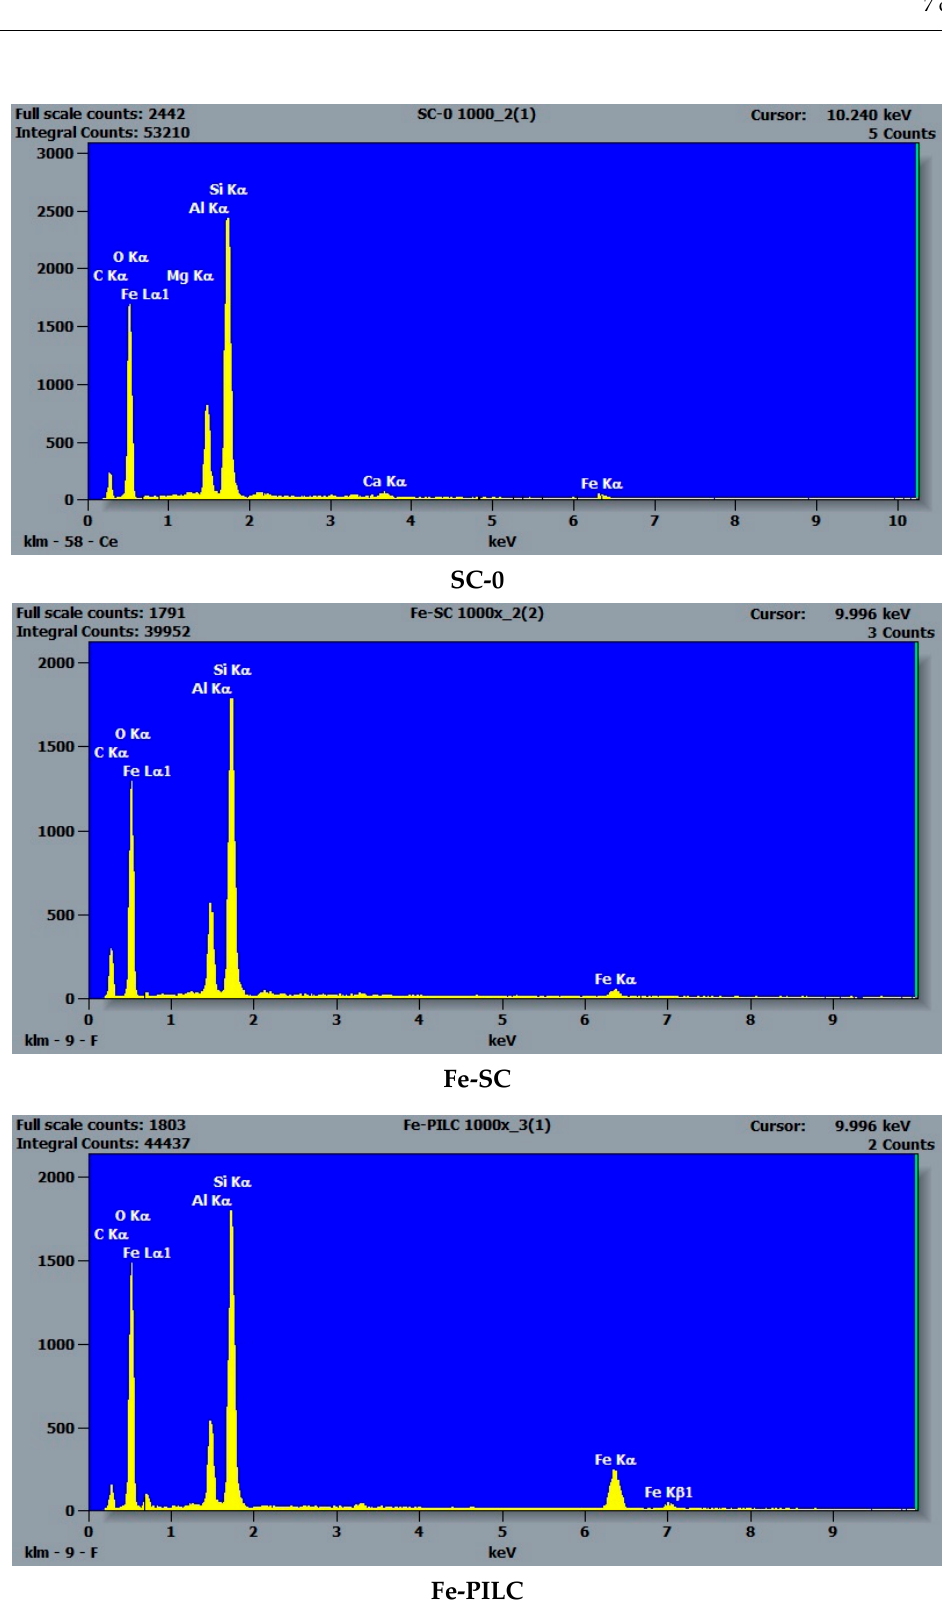
Figure 4. SEM-EDS spectra of the SC-0, Fe-SC, and Fe-PILC clay samples.